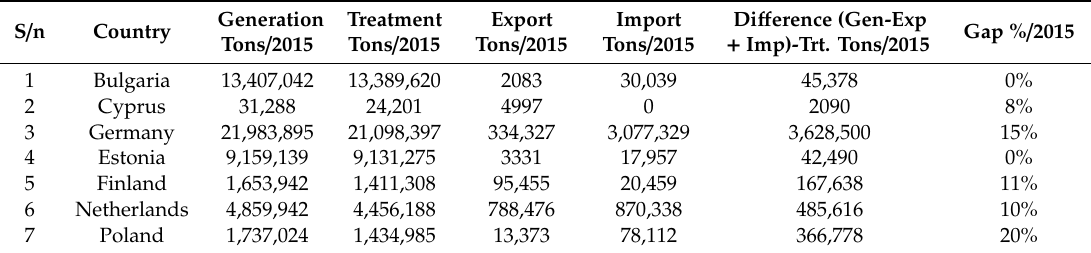
Table 3. Hazardous Waste Generated and Treated in selected European countries. Source: